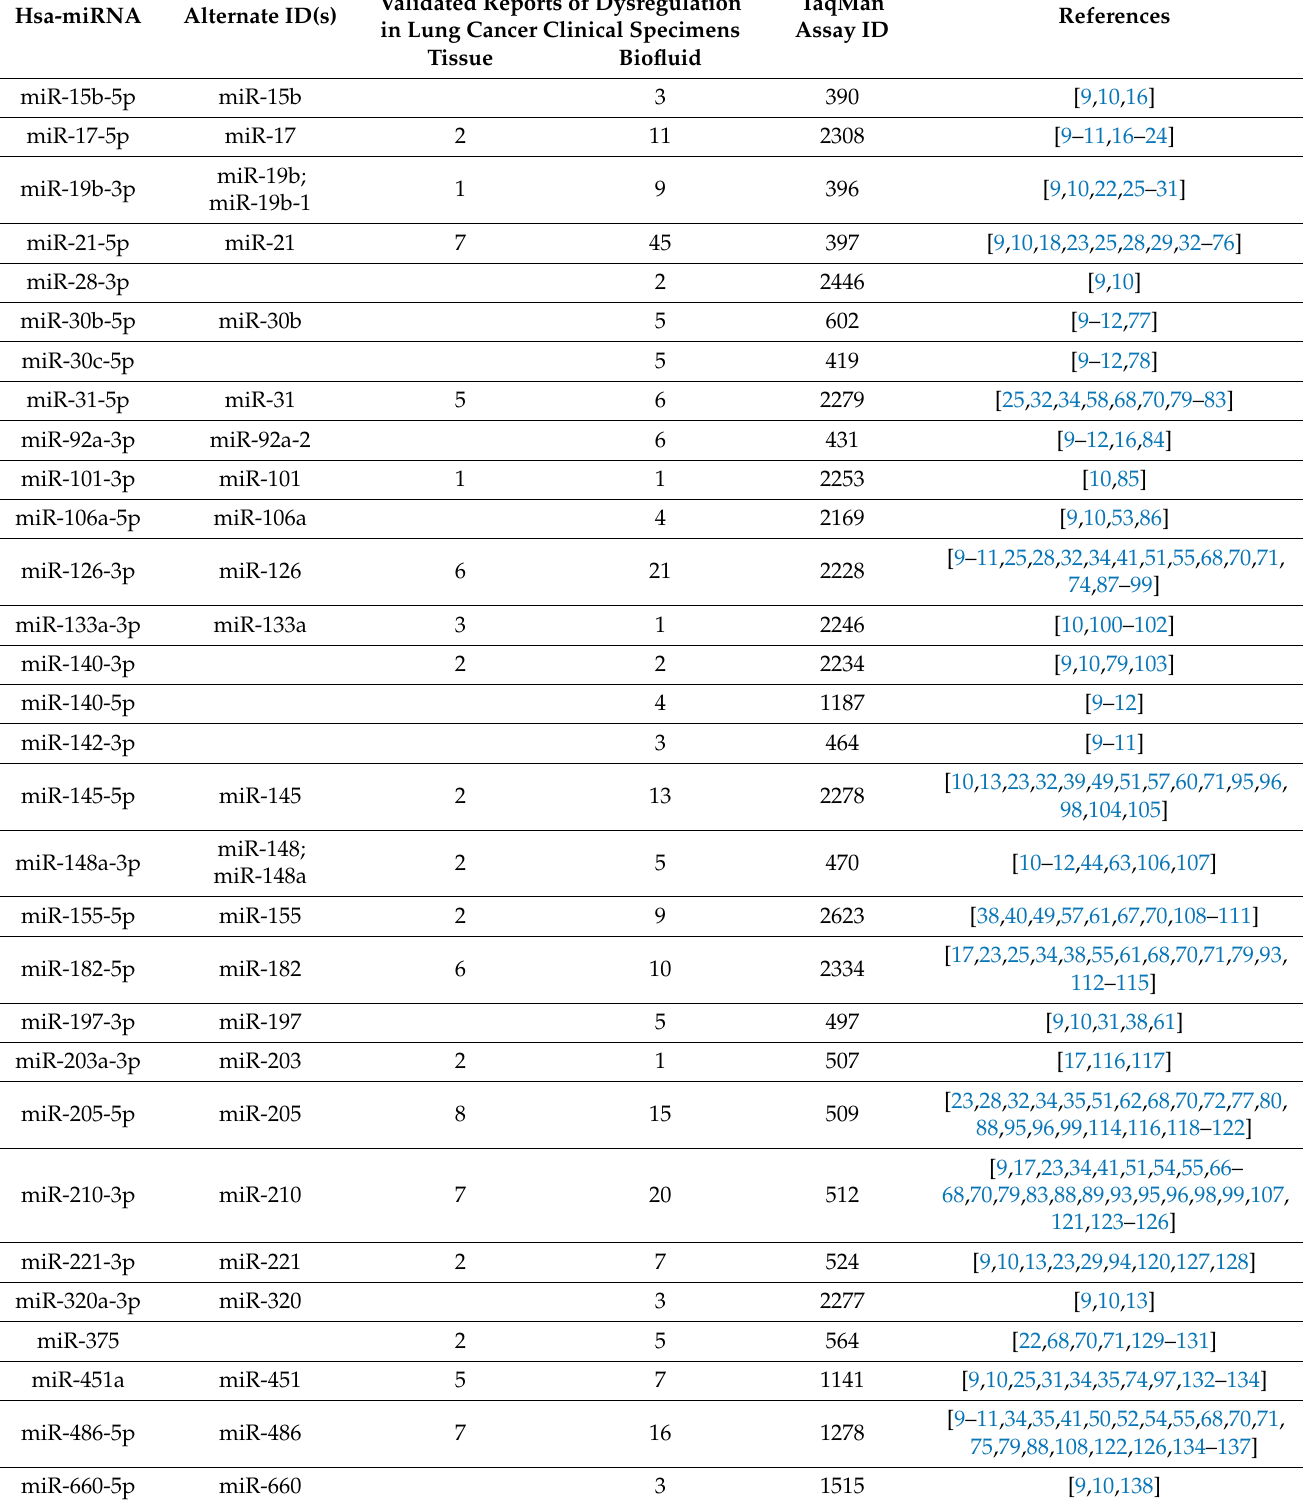
Table 2. miRNA candidates for serum-based early detection of lung